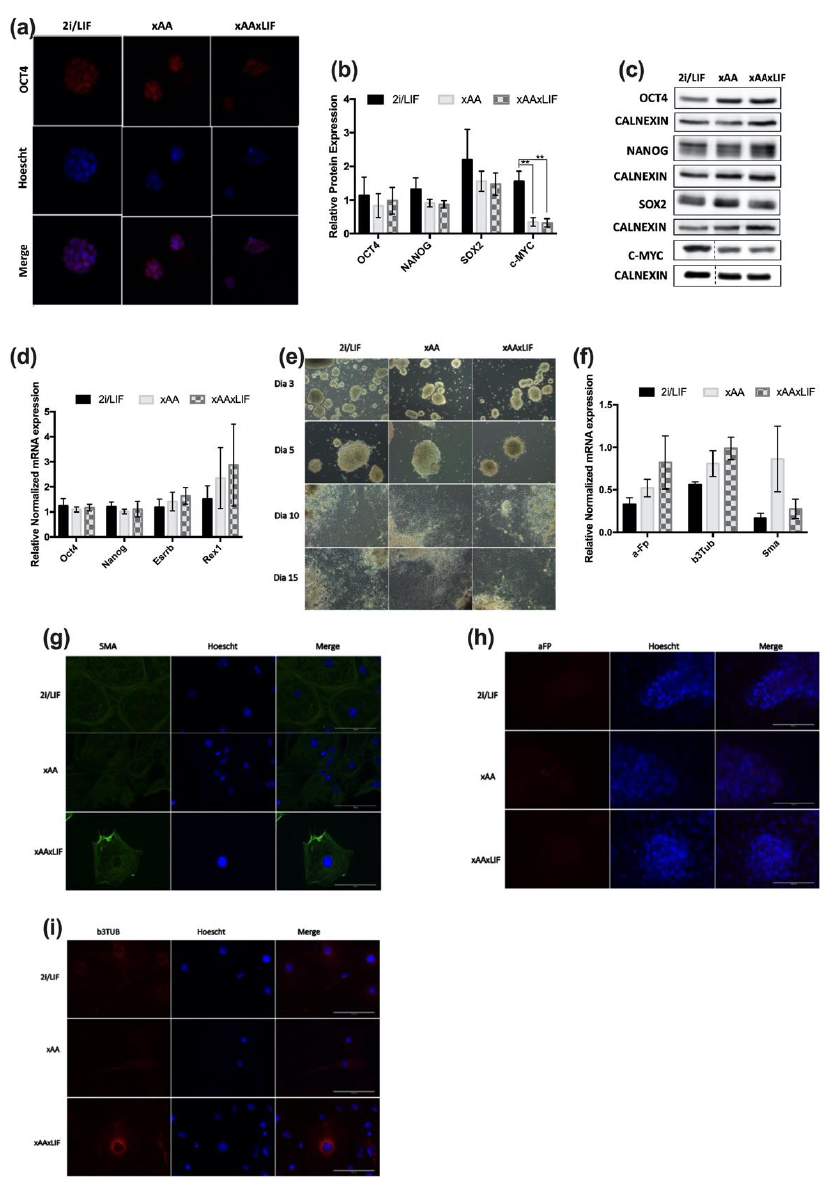
Figure 3. Pluripotency is not affected by Leucine and Arginine withdrawal . ( a ) Panel of fluores- cence microscopy images of colonies of each of experimental condition: 2i/LIF, xAA, and xAAxLIF stained for OCT4. The representative images of the colonies for each group of conditions were ob- tained after 48 h of culture (magnification 630×). ( b ) OCT4, NANOG, SOX2, and c-MYC protein levels were determined by Western blot after 48 h in experimental culture conditions (2i/LIF, xAA, and xAAxLIF) and were normalized to CALNEXIN levels, used as loading control. Results are pre- sented as mean ± SEM (OCT4: n = 5/protein/group; NANOG; SOX2 and c-MYC: n = 4/protein/group.